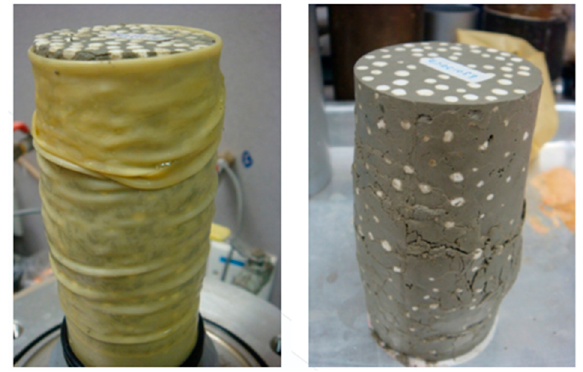
Figure 10. Elastoplastic failure for the higher E / S ratio.